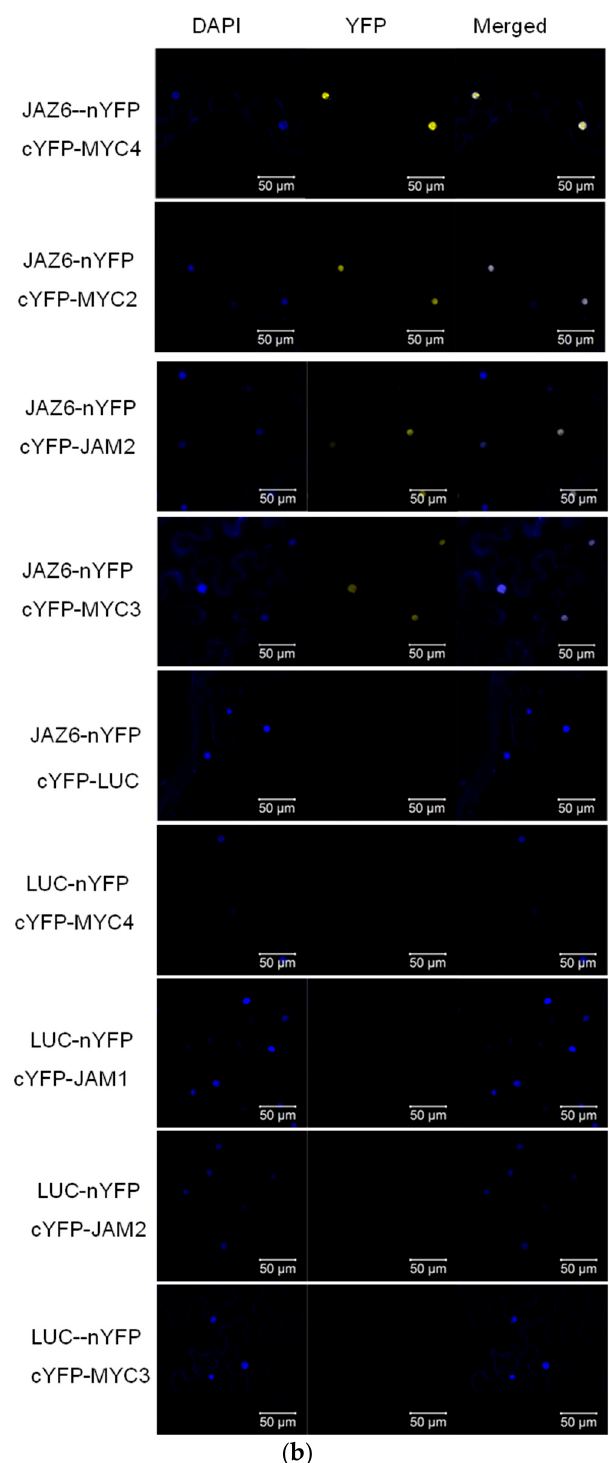
Figure 3. (a) yeast two-hybrid analysis of the interaction between JAZ and MYC2-like transcription factors. JAZ was ligated into pLexA and MYCs were ligated into pB42AD for yeast two-hybrid analysis.; (b) bimolecular fluorescence complementation analysis of the interaction between JAZ and MYCs. Yeast two-hybrid results showed that transcription factors MYC2, MYC3 and MYC4 interact with most of the JAZ proteins. The exceptions with no interactions are present between MYC2 and JAZ1, MYC3 and JAZ1 and JAZ8, MYC4 and JAZ8. Like the predicted results, JAM1 lacking the JID